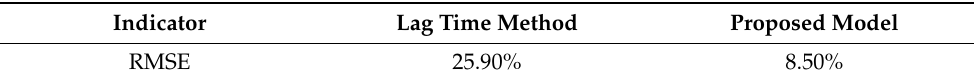
Figure 11. Comparison of the results from the proposed method with the measured data. Table 4. Comparison of output inversion error between the time lag method and the new method proposed in this